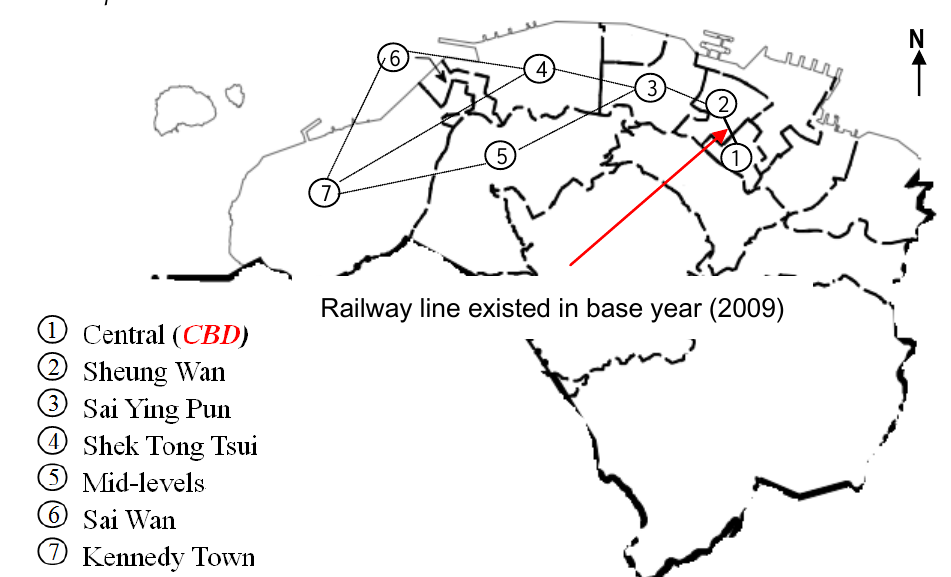
Figure 4. Residential locations in Central and Western District of Hong Kong